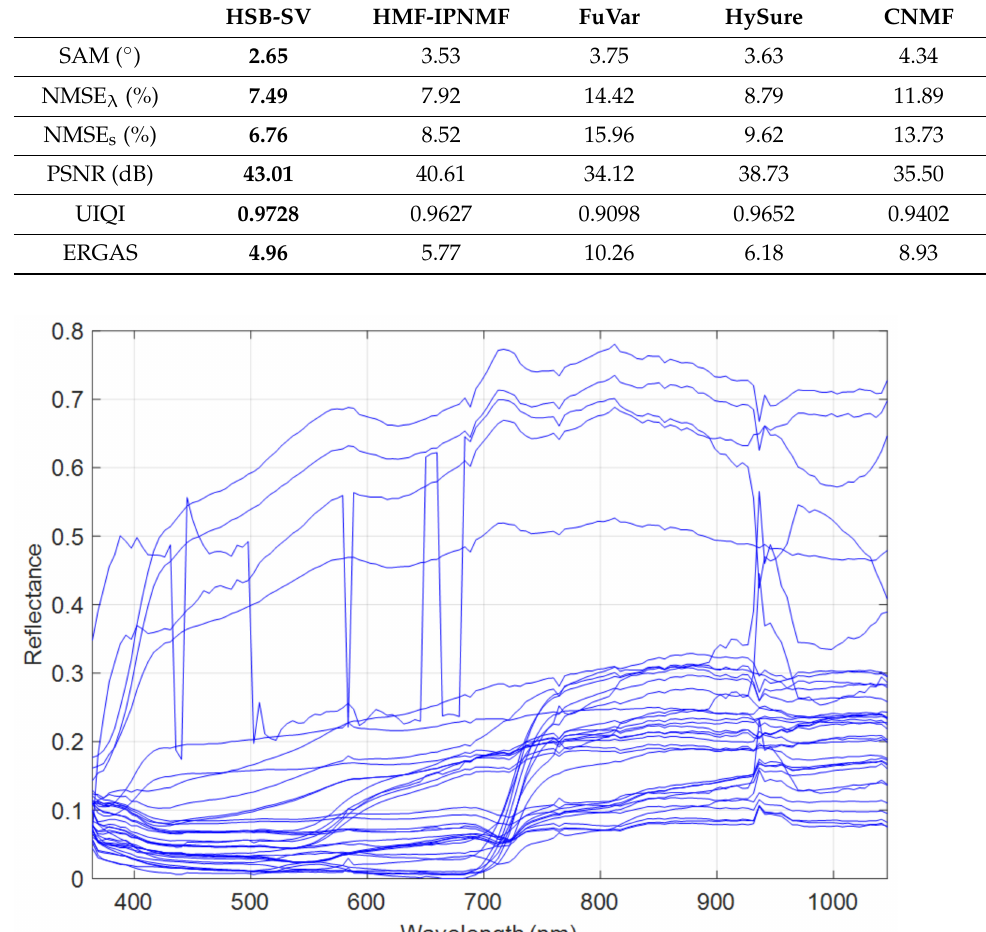
Table 5. Performance criteria for the synthetic dataset.